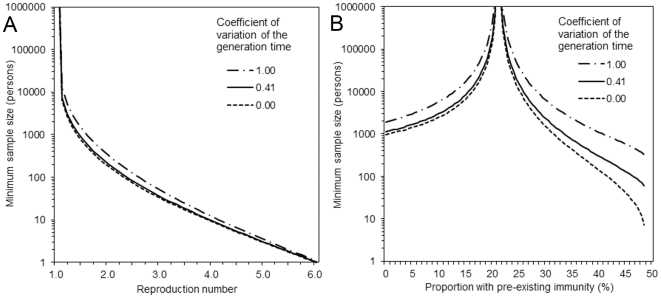
Sensitivity of minimum sample size for post-epidemic seroepidemiological studies to the reproduction number and the proportion of population with pre-existing immunity.(A). The minimum sample size with three different coefficients of variation (CVs) as a function of the reproduction number. (B). The minimum sample size with three CVs as a function of the proportion of population with pre-existing immunity. In (A), the proportion of population with pre-existing immunity is fixed at 0, and the estimates correspond to the margin of error of 10% and Type I and II errors at α = 0.05 and 1−β = 0.50, respectively. In (B), the reproduction number is fixed at 1.40, and the estimates correspond to the margin of error of 10% and Type I and II errors at α = 0.05 and 1−β = 0.50, respectively.